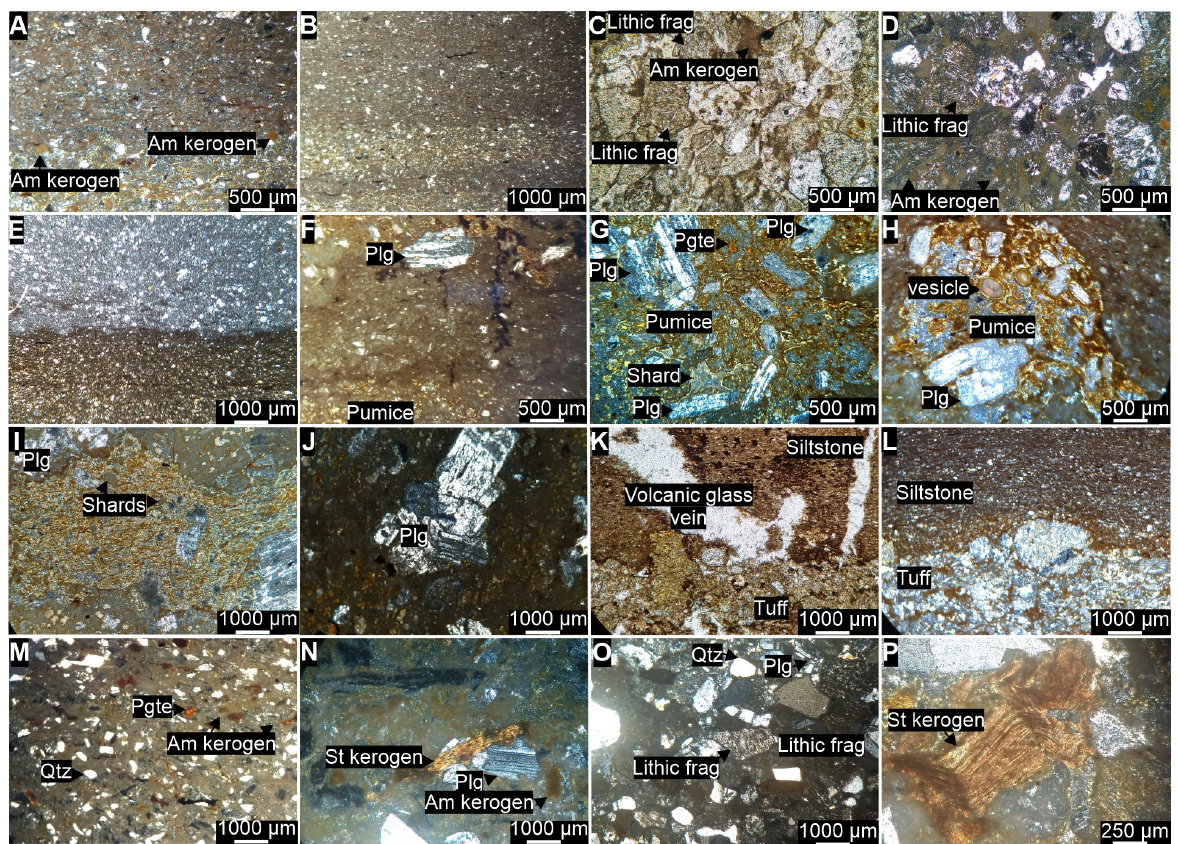
Figure 5. Petrographic photographs showing some details of the microfacies. a–b) Sample M.3, claystone-siltstone laminae under cross polarized light XPL. c–d) Sample M.5, Medium- to coarse-grained grauwacke with abundant rhyodacite lithic fragments, parallel polarized light PPL and XPL, respectively. e) Sample M.7, claystone-siltstone laminae under XPL. f–h) Sample M.13, tuff under XPL, ash matrix with abundant brown kerogen (f), phenocrystals of < 1 mm of plagioclase in pumice (g) showing vesicles (h). i–j) Sample M.14, lapilli tuff, glass, and ash matrix with phenocrystals of > 3 mm of plagioclase under PPL and XPL, respectively. k–l) Sample M.17, siltstone-tuff laminae under PPL and XPL, respectively. m–n) Sample M.25, lapilli tuff under XPL, matrix compound of ash and clastic fine grains with phenocrystals of quartz, plagioclase and oxides, abundant amorphous (Am) kerogen and structured (St) kerogen, and accretionary lapilli filled with palagonite (Pgte) are observed. o–p) Sample M.27, medium- to coarse-grained tuffaceous litharenite under XPL, poor selected and grain supported matrix with sub-rounded to rounded quartz, plagioclase, lithic fragments in welded ash altered to clay minerals (o), structured kerogen (p) grains are abundant as well as